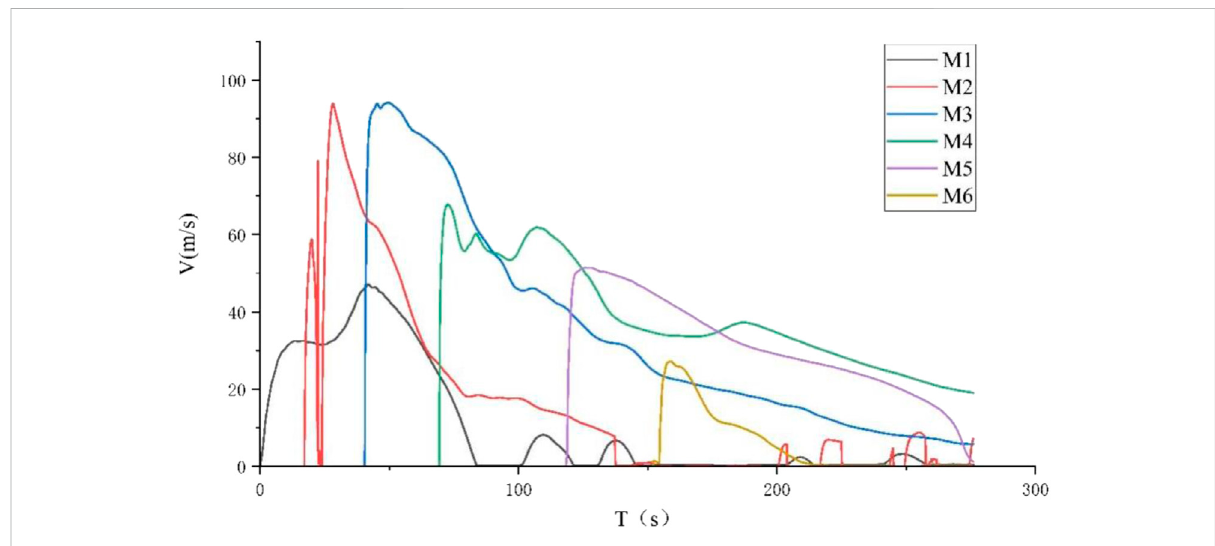
FIGURE 4 Velocity characteristics of different monitoring